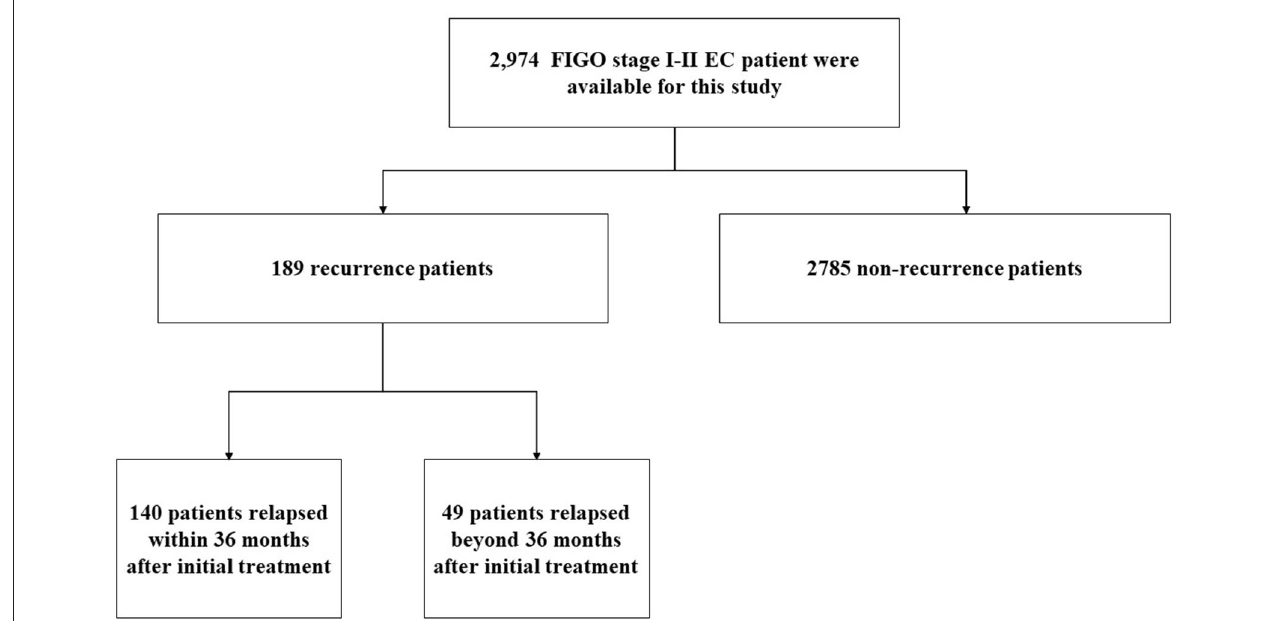
FIGURE 1 | Flowchart of this